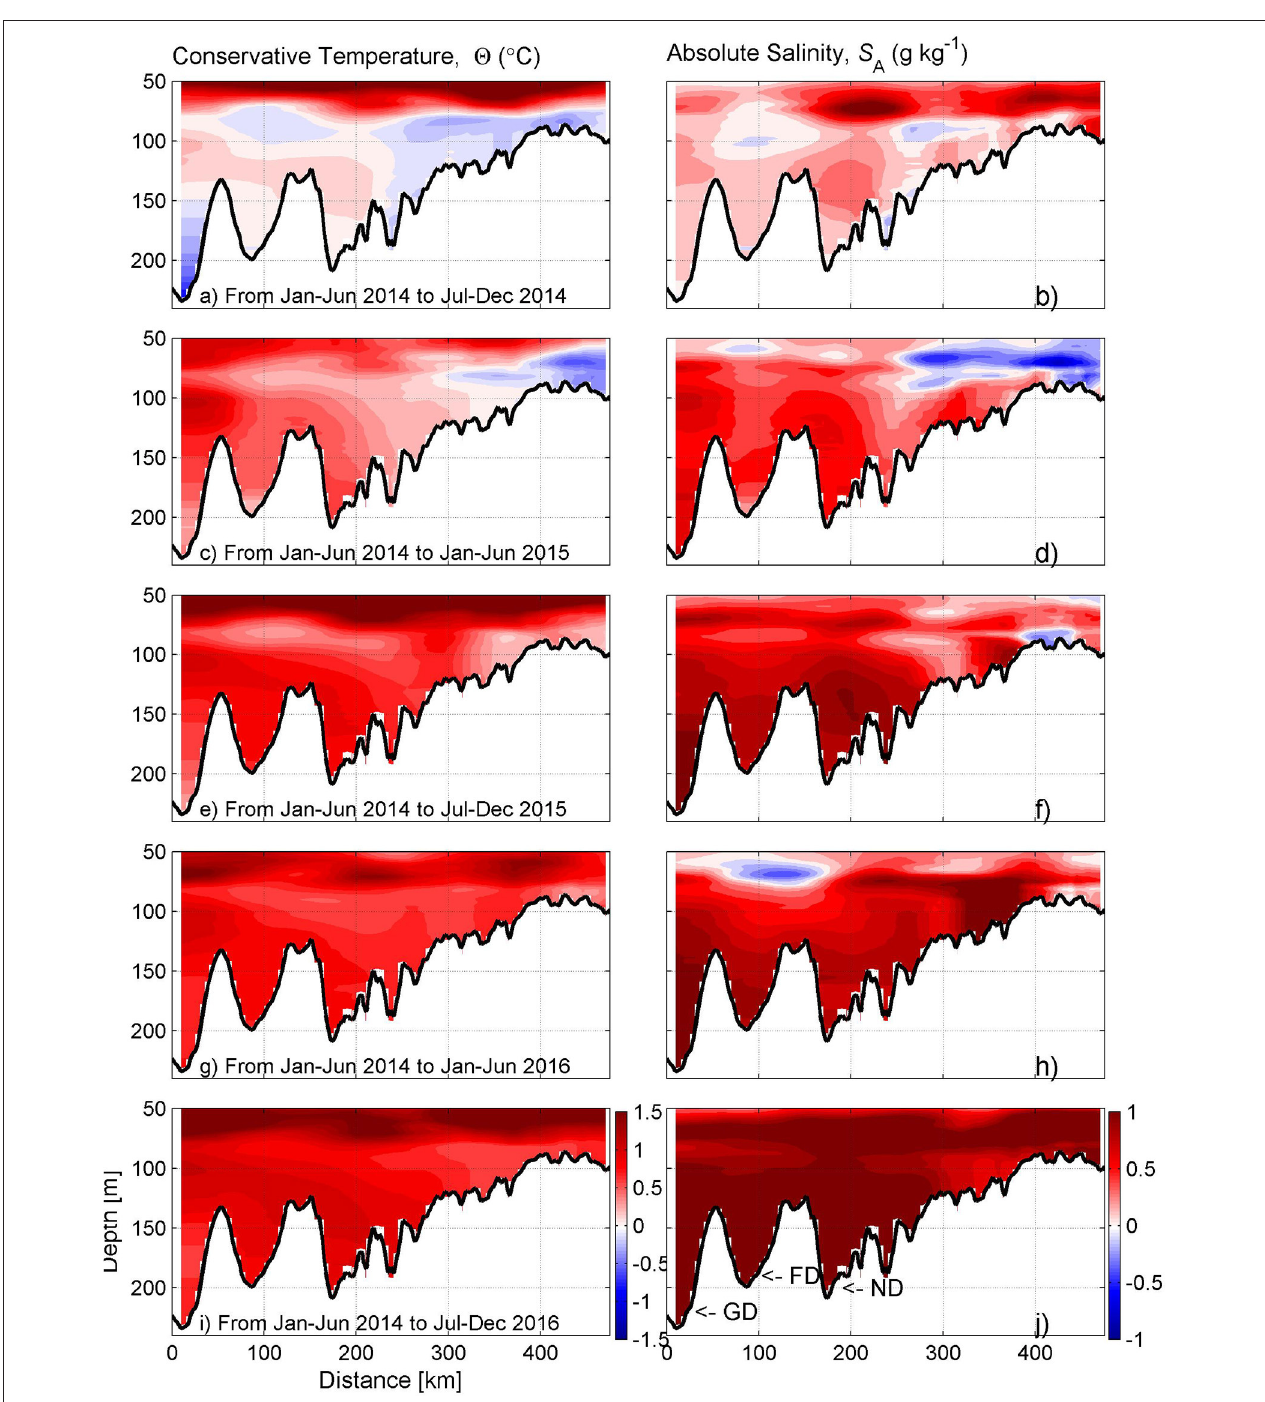
FIGURE 10 | Vertical sections of half-year averaged temperature and salinity changes relative to the mean fields in the period January-June 2014 along the pathway from Gotland Deep to the Gulf of Finland in July-December 2014 (a, b) , January-June 2015 (c, d) , July-December 2015 (e, f) , January-June 2016 (g, h) , July-December 2016 (i, j) . Locations of the Gotland Deep (GD), Fårö Deep (FD), and Northern Deep (ND) are shown in the lowermost right panel. the Fårö Deep (12.79 g kg − 1 ), Northern Deep (11.92 g kg − 1 ), (Franck et al., 1987; Matthäus and Franck, 1992; Fischer and and Northern Baltic Proper (Kõpu West, 11.77 g kg − 1 ) were Matthäus, 1996; Mohrholz et al., 2015). The highest salinity registered in May 2016, July 2016 and August 2016, values during the study period in the near bottom layer of